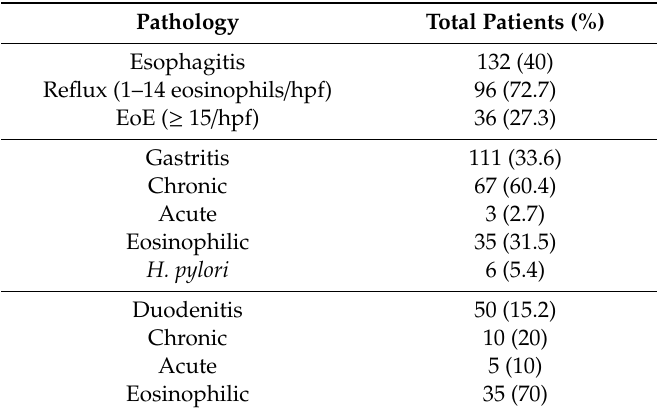
Table 2. Frequencies of EGD biopsy findings.